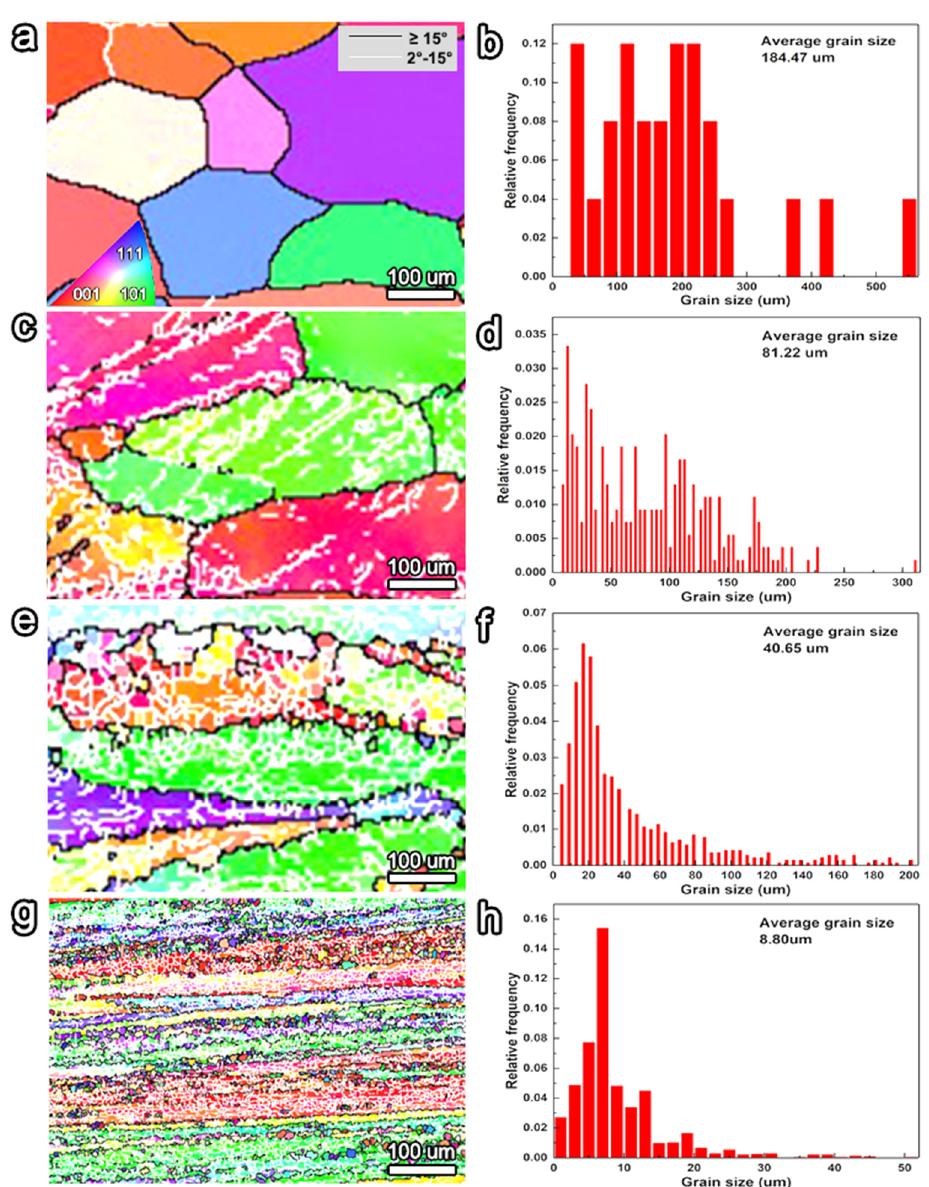
Figure 2. EBSD images of the initial sample ( a ) and deformed samples at area reduction ratio of 19% ( c ), 58% ( e ) and 91% ( g ), and their corresponding grain size distribution ( b , d , f , h ); different colors represent different grain orientations; white lines represent SAGBs, while black lines represent large angle grain boundaries (LAGBs, boundary angle ≥ 15°).